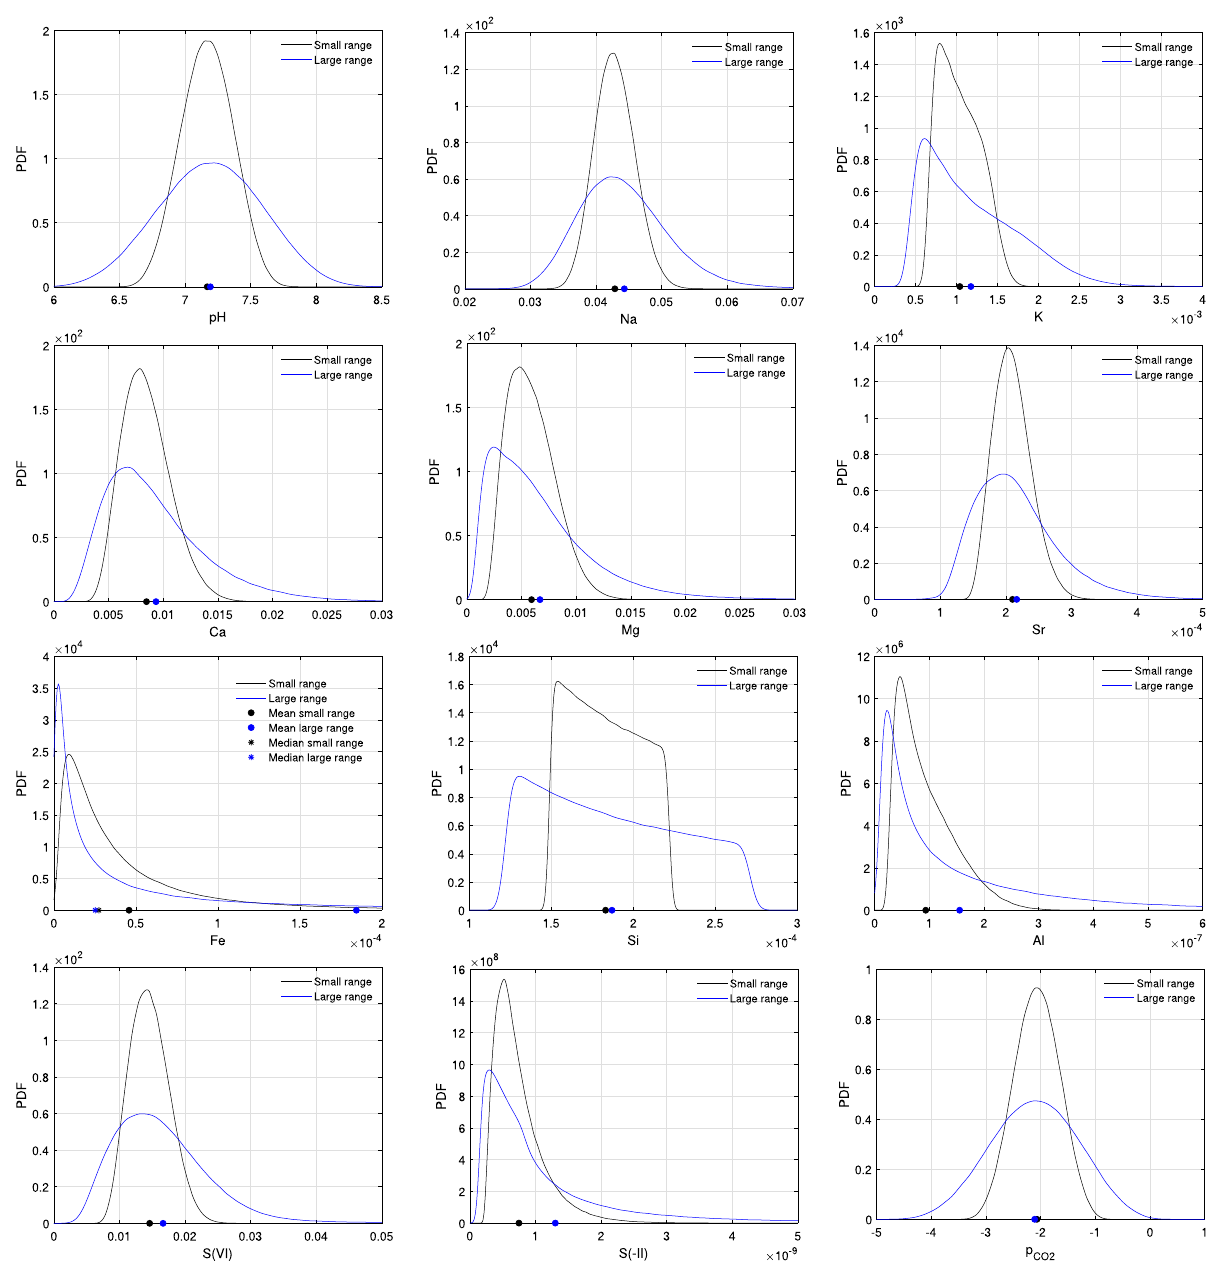
Figure 2. Marginal distributions and means of the QoI for the small range case (black curves) and the large range case (blue curves) estimated with 10 6 realizations of the surrogate models and the kernel density estimation method 32